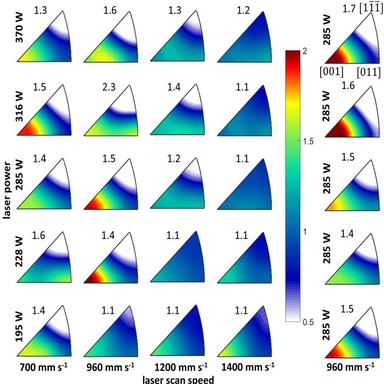
Crystallographic texture plots for as-built combinatorial sample. Units for the color bar are multiples of a uniform distribution (mud). A value of 1 mud indicates no preferred texture. The texture index, L2 -norm of the orientation distribution function, is listed for each dataset. Similarly, a texture index of 1 corresponds to a uniform distribution with no preferred texture. The texture index for the repeats at the default settings has a mean (standard deviation) of 1.5 (0.1).